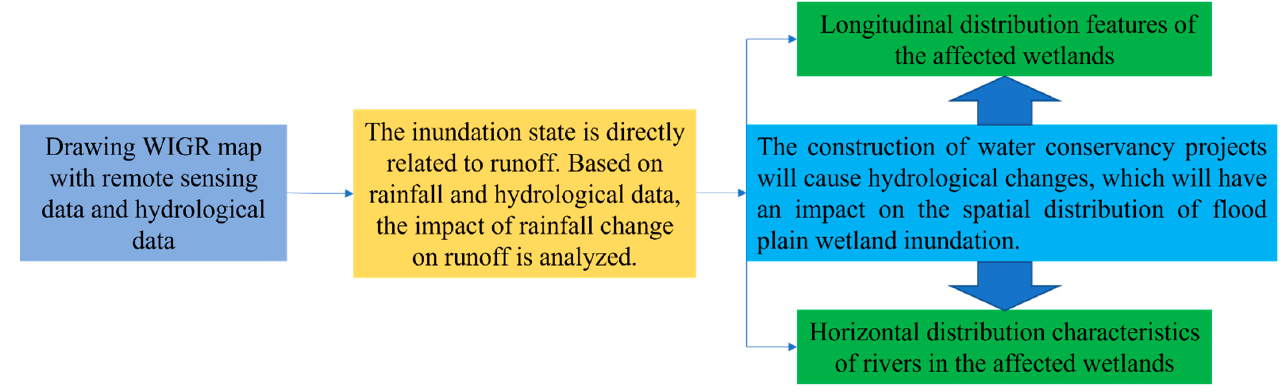
Figure 4. Evaluation system process.